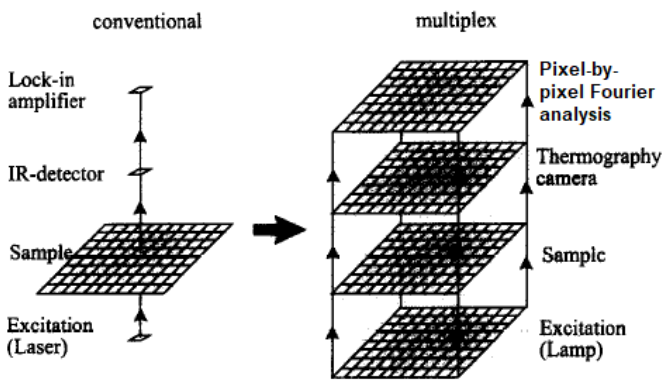
Figure 49. The schematic drawing showing the comparison of the setups for the photothermal radiometry and the lock-in thermography technique. Reprinted from Revue Generale de Thermique, Volume 37, Wu, D.; Buss, G. Lock-in Thermography for Non-destructive Evaluation of Materials, Page 693–703, Year 1998 with permission from Elsevier